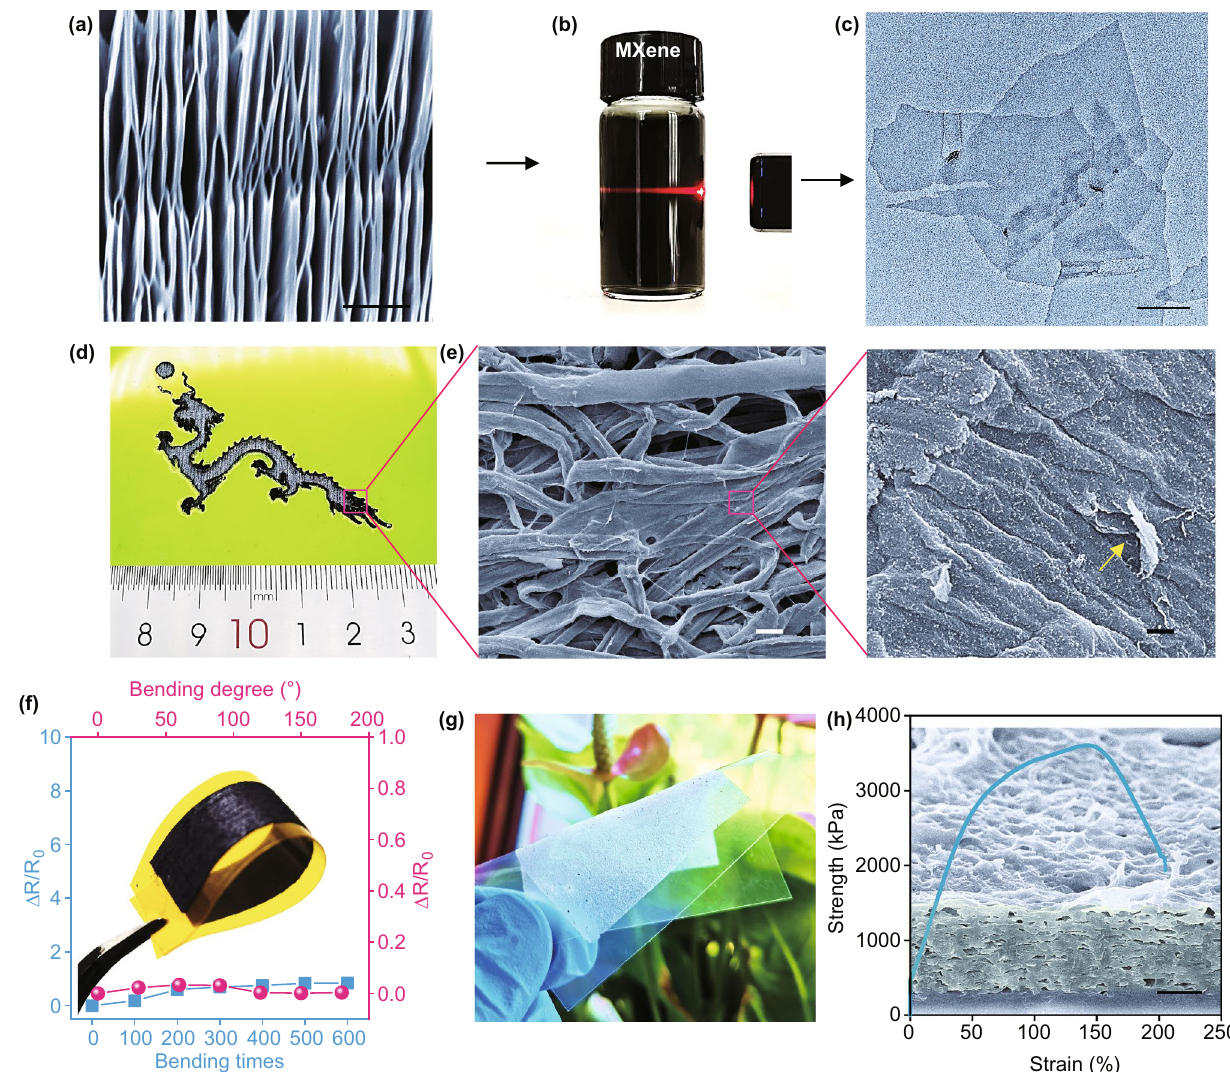
Fig. 2 Structural characterization of the sensing materials and electrode. a SEM image of the accordion-microstructured MXene. The scale bar is 500 nm. b Tyndall effect of the Ti 3 C 2 T x nanosheets solution. c TEM image of the Ti 3 C 2 T x nanosheets. The scale bar is 100 nm. d Laser pat- tern of a Chinese dragon. e SEM image and its corresponding large view of the Ti 3 C 2 T x nanosheets coated n-WF. The scale bar is 40 µm and 500 nm, respectively. f Bending deformation of the Ti 3 C 2 T x electrode and its corresponding resistance change. Inset is the optical image of